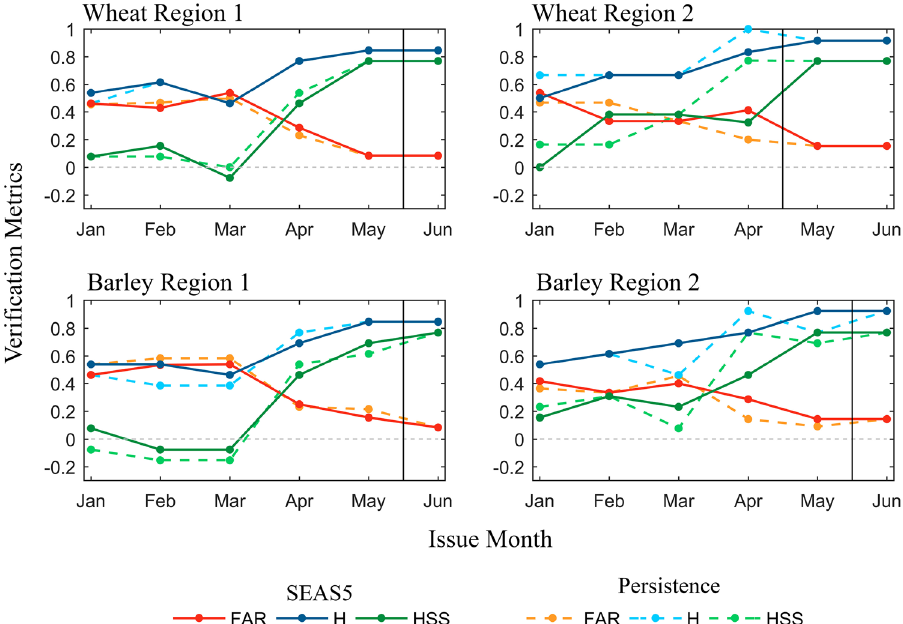
Figure 3. Forecast verification metrics: False alarm ratio FAR (orange), hit rate H (blue), and Heidke skill score HSS (green) for wheat yield anomalies (top) and barley yield anomalies (bottom) located in Region 1 (left) and Region 2 (right). Metrics for yields obtained with dynamical forecast SEAS5 are displayed in solid lines, whereas metrics for yields obtained with persistence forecasts are shown in dashed lines. The figure was produced in Python 3.8 (https:// www. python.